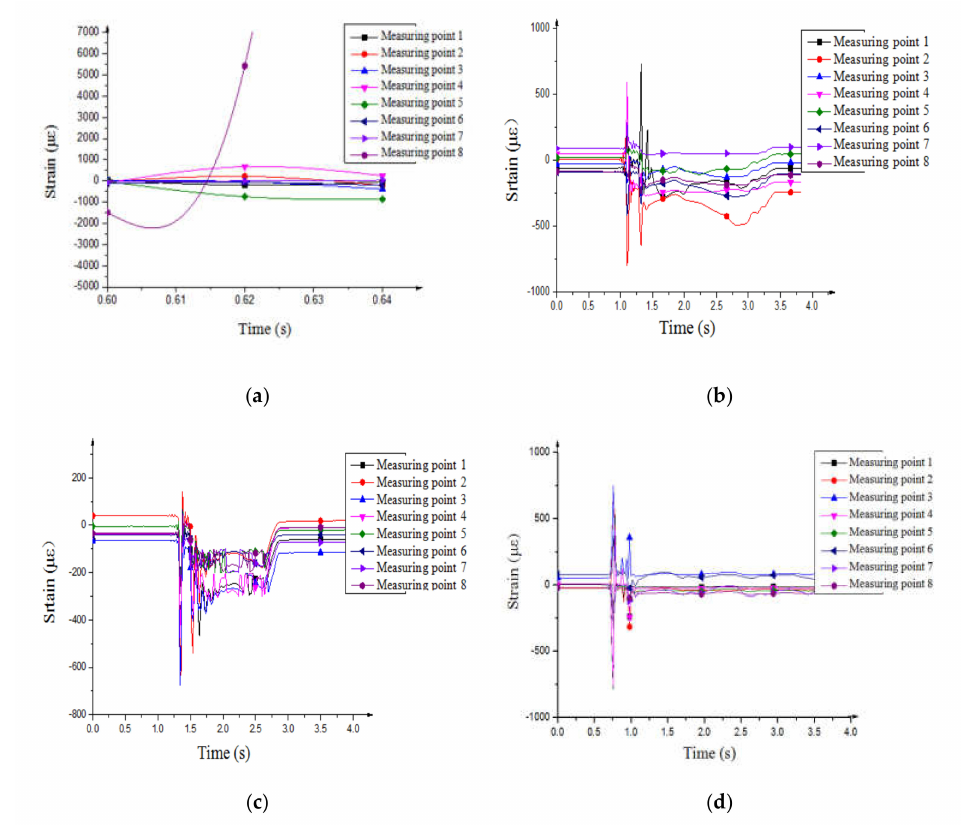
Figure 12. Strain time-history curves of W1 to W4. ( a ) W1; ( b ) W2; ( c ) W3; ( d )